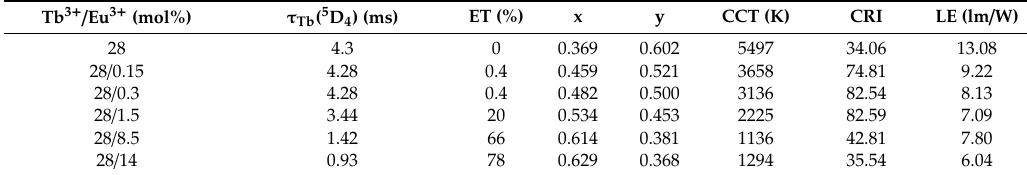
Table 1. Decay time, energy transfer, color coordinate (CC), color-correlated temperature (CCT), color rendering index (CRI), and luminous e ffi cacy (LE) of the ceramic phosphor plate as a function of Eu 3 +